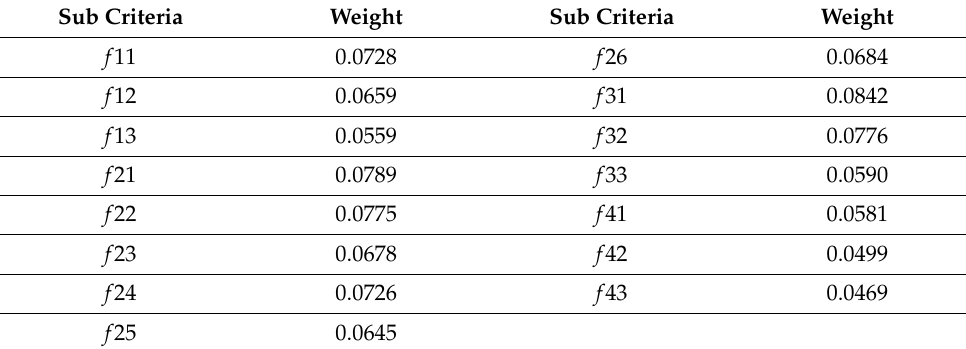
Table 6. AHP ranked the